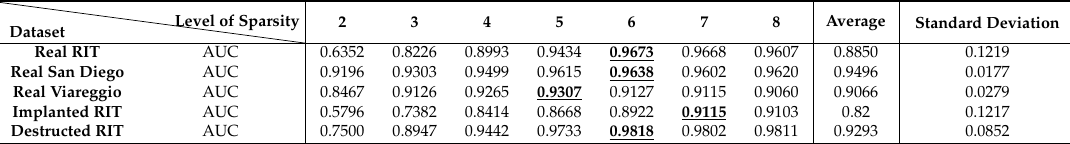
Table 3. Effect of the level of sparsity in the SWJSR detector for all datasets. (The bold one is the higher).